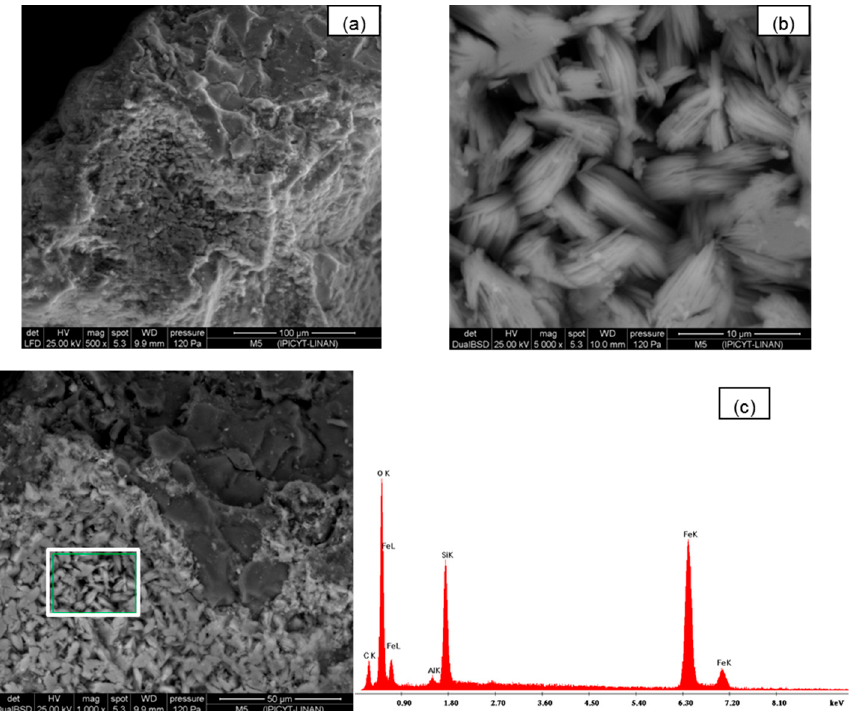
Figure 1. ( a , b ) SEM images of silica sand coated with Fe(III) untreated; ( c ) Fragment where EDS (white box) and chemical spectrograph quantification EDS of adsorbent was performed.